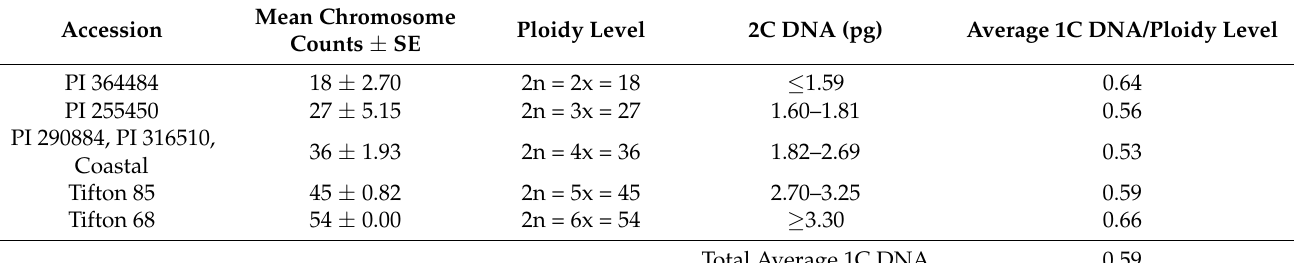
Table 1. Range of 2C DNA contents and haploid genome size (1C DNA) in picograms (pg) for accessions in the USDA forage bermudagrass germplasm. Ploidy levels were classified based on their 2C DNA content. The 2C DNA content for accessions with counted chromosome numbers were divided by their ploidy number to obtain their 1C DNA value (pg). The mean 1C DNA values of each ploidy level were averaged, followed by averaging the 1C DNA from all ploidy levels to generate the overall genome size.